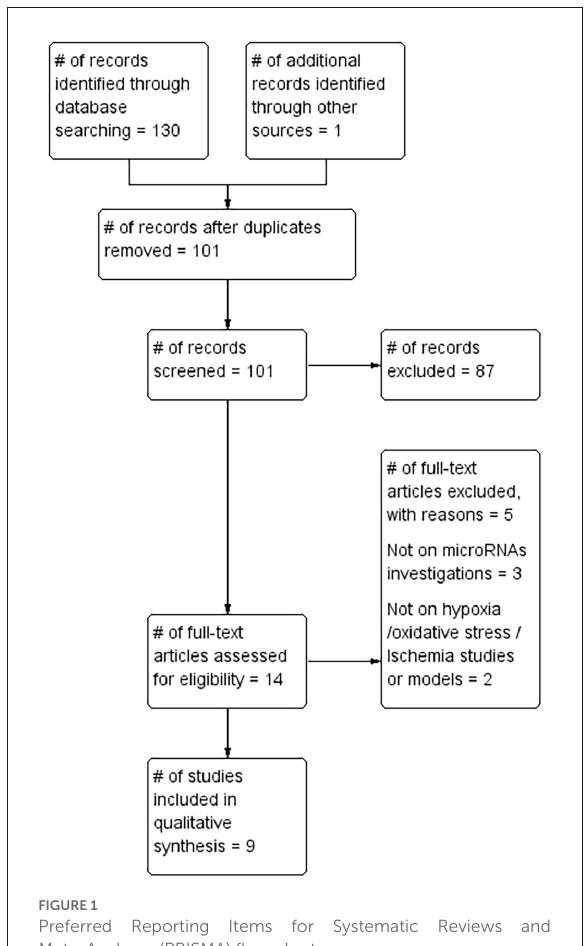
FIGURE1 Preferred Reporting Items for Systematic Reviews and Meta-Analyses (PRISMA) flow chart.